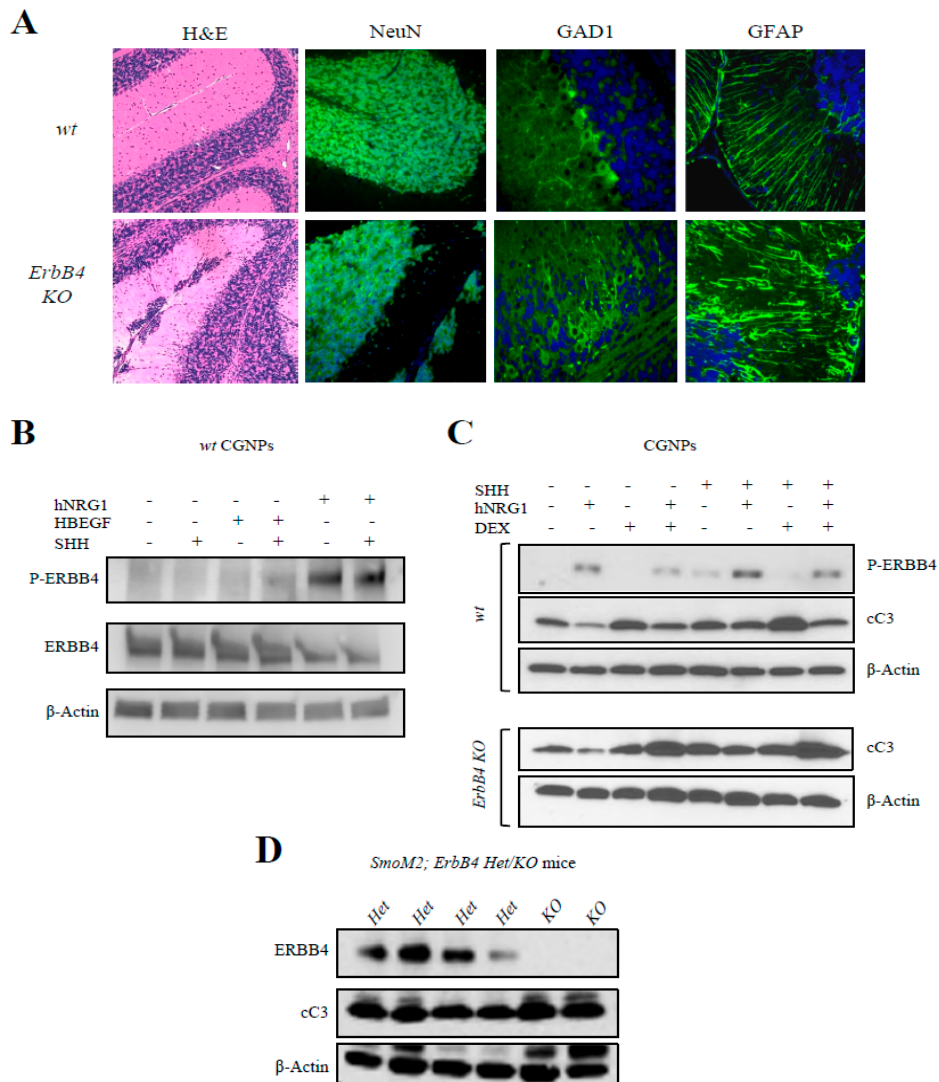
Figure 2. ERBB4 deletion impairs migration during cerebellum development and its activation protects CGNPs from apoptosis. ( A ) Representative immunofluorescence images of the indicated proteins in p20 wt and ErbB4 KO mouse cerebellum. ( B ) Western blot analysis of indicated proteins in CGNPs from wt p5 mice treated with the indicated compounds ( n ≥ 3). ( C ) Western blot analysis of the indicated proteins in CGNPs from wt and ErbB4 KO p5 mice treated with the indicated compounds ( n ≥ 3). ( D ) Western blot analysis of the indicated proteins obtained from p15 cerebellum from SmoM2; ErbB4 Het or KO mice. The uncropped blots and molecular weight markers are shown in Figures Supplementary Materials.